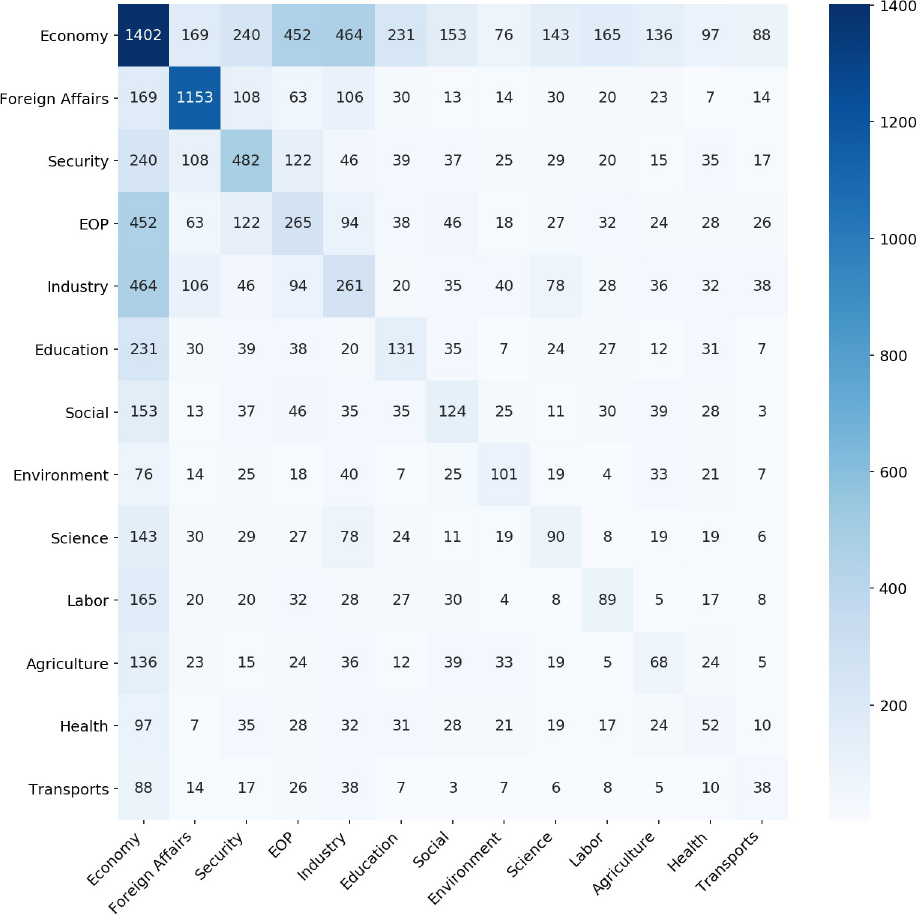
Fig 6. Co-sponsorship of cabinets’ policy-areas. The main diagonal stands for the number of decrees with only one label.